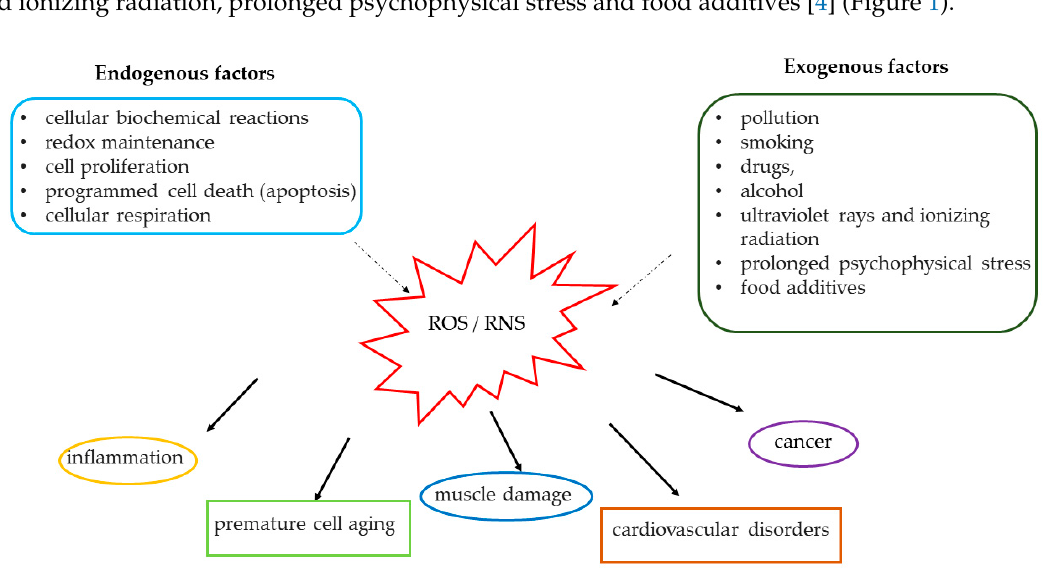
nitrogen species Figure 1. Causes and effects induced by the increase in reactive oxygen species (ROS) and reactive nitrogen species (RNS).